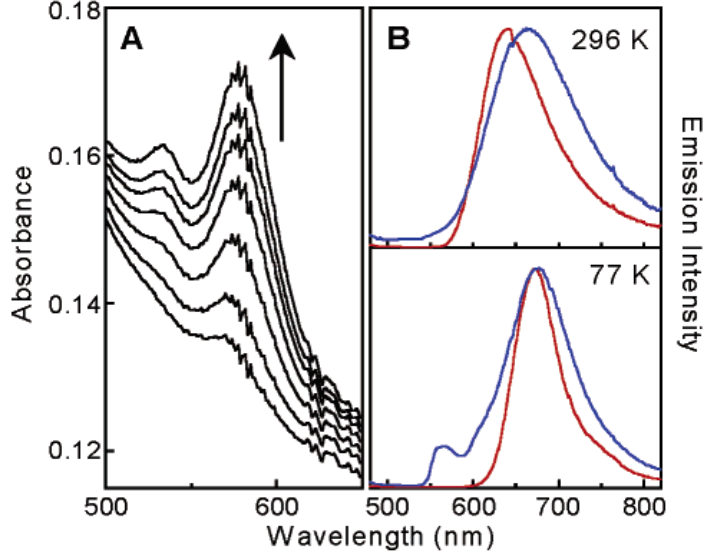
Figure 11. (a) UV-visible absorption spectra of a thin film of Pt(Me recorded during exposure to acetonitrile vapor. (b) Solid-state emission spectra of Pt(Me bzimpy)Cl + (Cl – salt) before (blue lines) and after (red lines) exposure to methanol 2 vapor. Reproduced with permission from